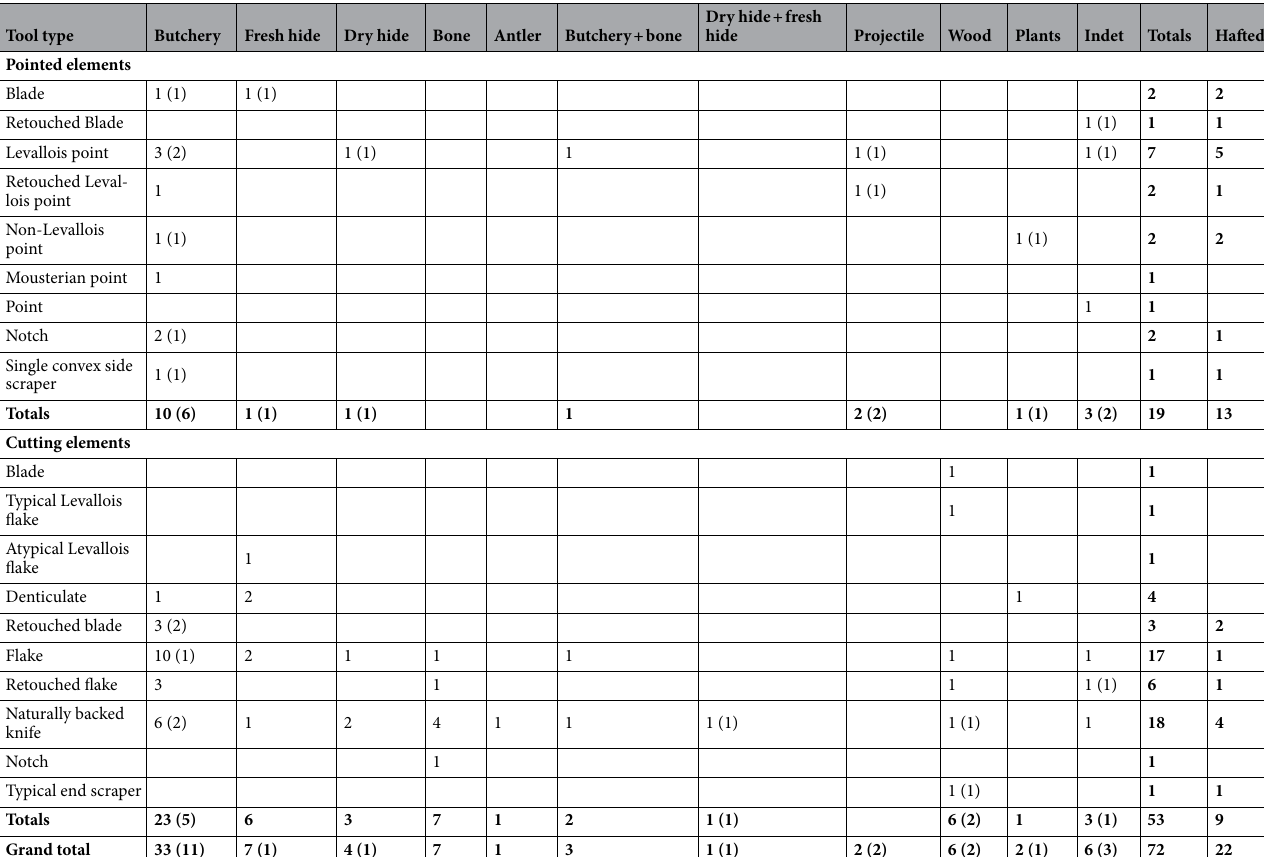
Table 3. Functional results for the pointed and cutting elements of the archaeological sample that exhibit use-wear subdivided by typological categories, considering the worked materials and hafted tools. Significant values are in bold. The numbers in parentheses show the total number of hafted tools for each typological category and worked